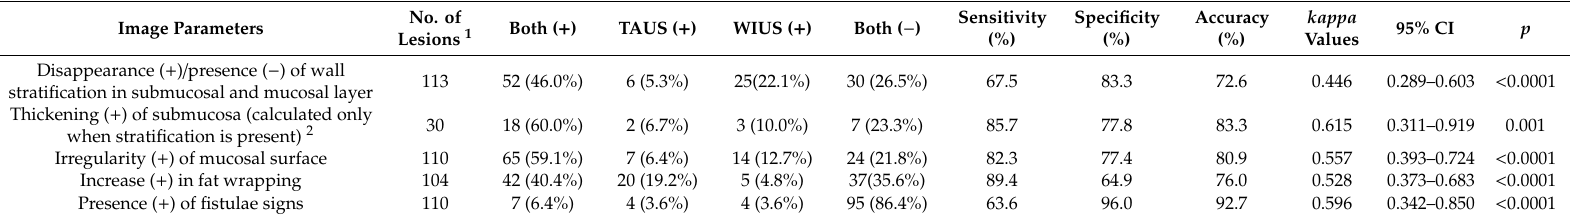
Table 2. Agreement between TAUS and WIUS for imaging findings of